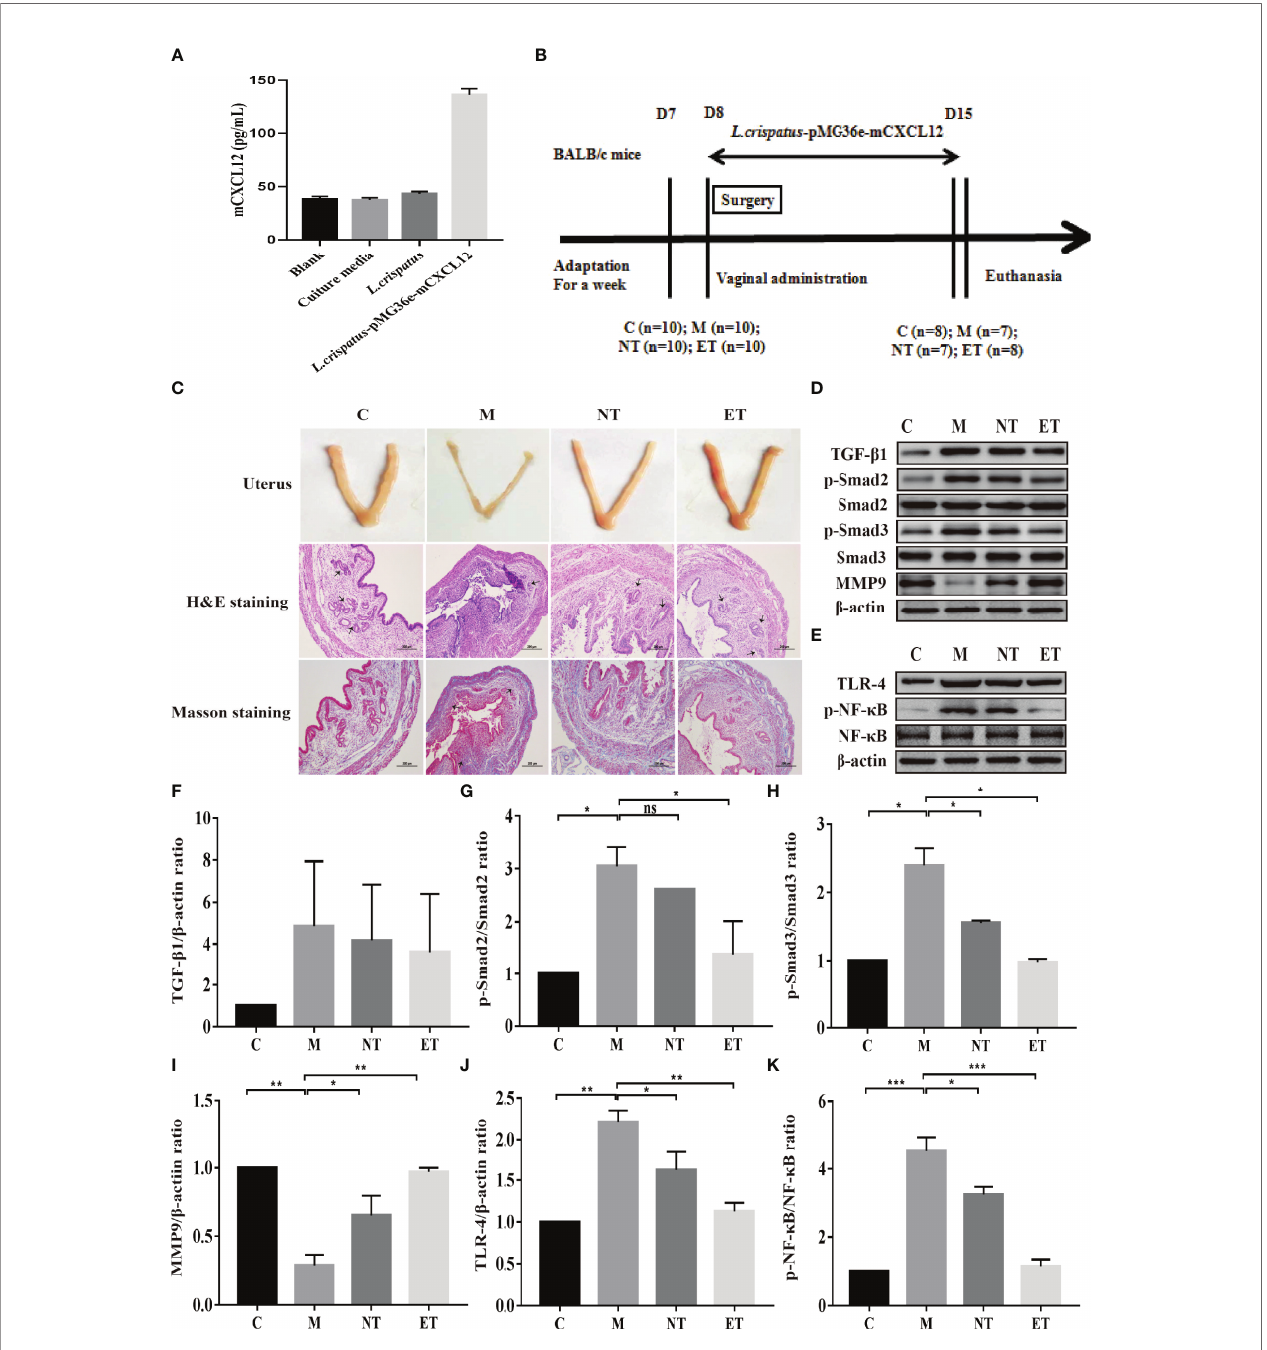
FIGURE 1 | Effect of L. crispatus -pMG36e-mCXCL12 on the expression of proteins associated with the TGF- b 1/Smads and TLR4/NF- k B signalling pathway in intrauterine adhesion mice. (A) mCXCL12 in-vitro bacterial expression. (B) Experimental scheme to evaluate the effects of L. crispatus -pMG36e-mCXCL12 on the prevention of intrauterine adhesion in mice. (C) H&E staining was used to observe uterine in fl ammation, and Masson staining was used to observe collagen deposition in the uterine tissue of intrauterine adhesion mice (magni fi cation: × 100). (D) Expression of fi brotic-related proteins in the uterine tissue of intrauterine adhesion mice. (E) Expression of in fl ammatory-related proteins in the uterine tissue of intrauterine adhesion mice. Effect of L. crispatus -pMG36e-mCXCL12 on fi brotic-related TGF- b 1 (F) , p-Smad2/Smad2 (G) , p-Smad3/Smad3 (H) , MMP-9 (I) proteins in the uterine tissue of intrauterine adhesion mice. Effect of L. crispatus - pMG36e-mCXCL12 on in fl ammatory-related TLR4 (J) , p-NF- k B/NF- k B (K) proteins in the uterine tissue of intrauterine adhesion mice. C group, Control group; M group, laparotomy was used to construct a model of intrauterine adhesion; NT group was treated with L. crispatus for intrauterine adhesion mice; ET group was treated with L. crispatus -pMG36e-mCXCL12 for intrauterine adhesion mice. One-way ANOVA analysis was used for statistical analysis and all data are presented as mean ± standard deviation (SD). ns, P > 0.05; *P < 0.05; **P < 0.01; ***P <